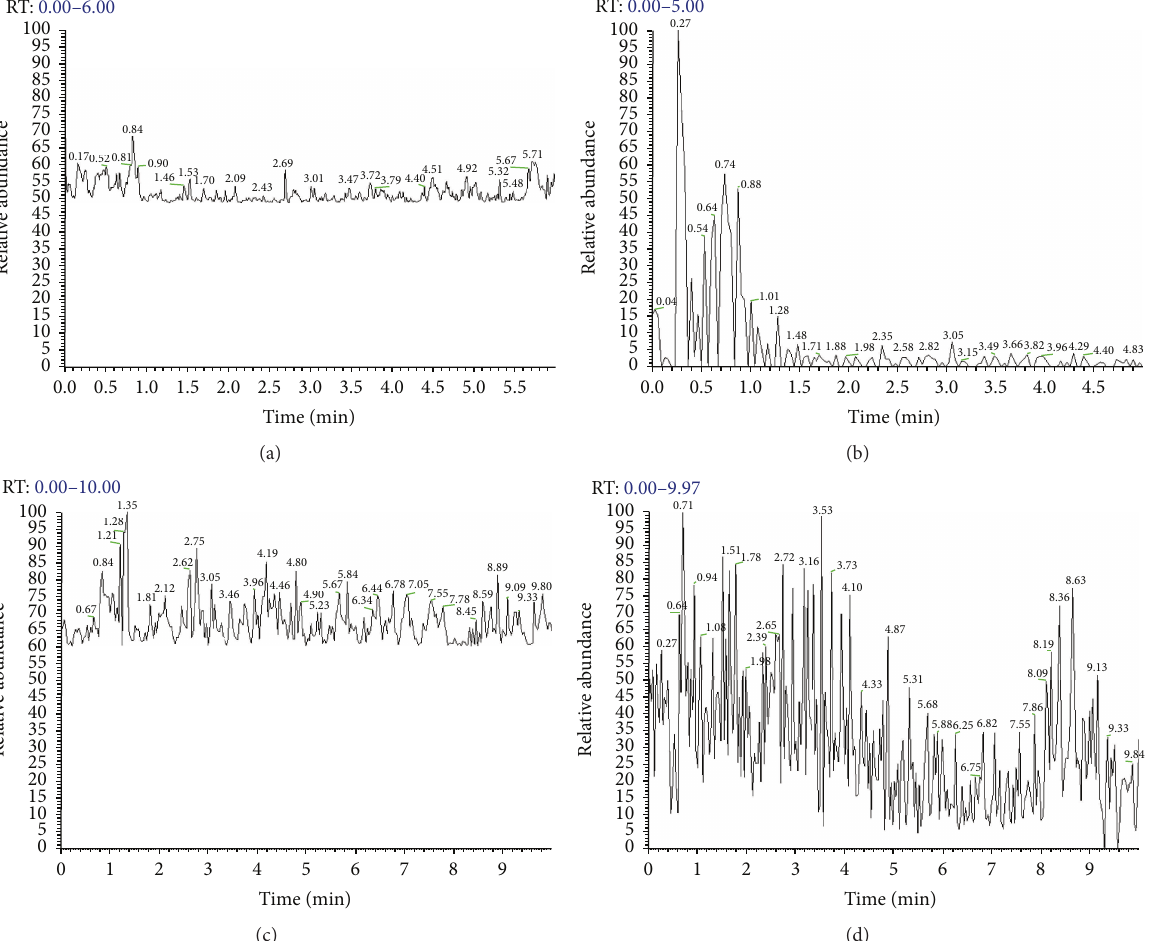
Figure 6: Chromatograms of quantifications of the various antibiotics in one of the samples. (a) Chloramphenicol; (b) erythromycin; (c) florfenicol and florfenicol amine; and (d) oxytetracycline.